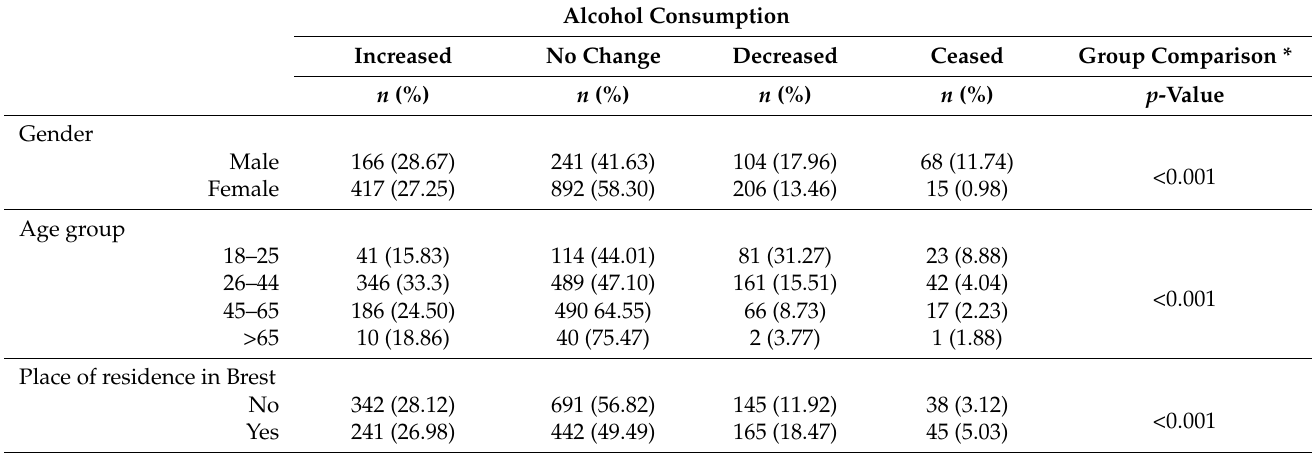
Table 1. Descriptive statistics for socio-demographic variables, medical and psychiatric history, and other addictive